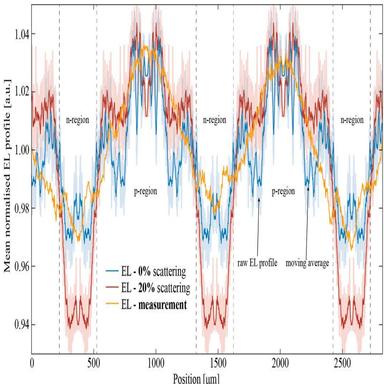
Effect of scattering at imperfectly flat interfaces: In the blue case no light is scattered and in the red case 20% of incident light is scattered. The referential measurement is shown in orange. (For interpretation of the references to colour in this figure legend, the reader is referred to the Web version of this article.)